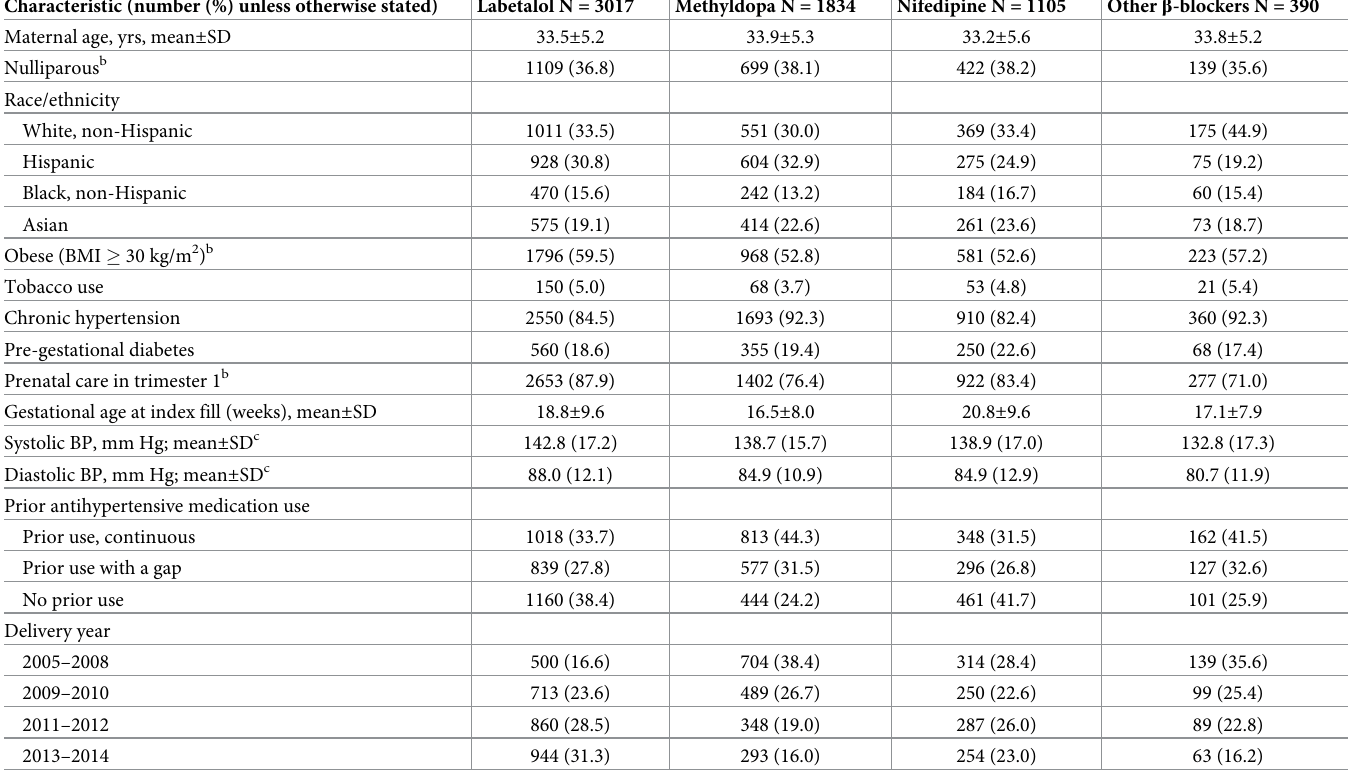
Table 1. Baseline characteristics of the population before weighting, by treatment group a . Characteristic (number (%) unless otherwise stated)